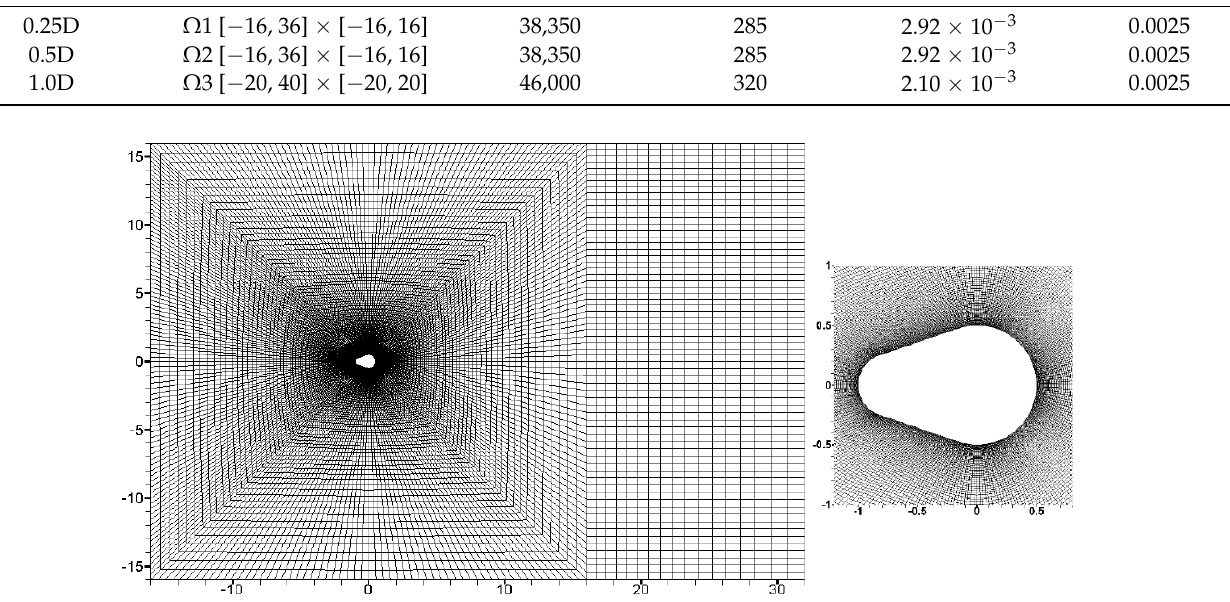
Figure 4. Finite element mesh for flow past a 0.5D crescent iced conductor.